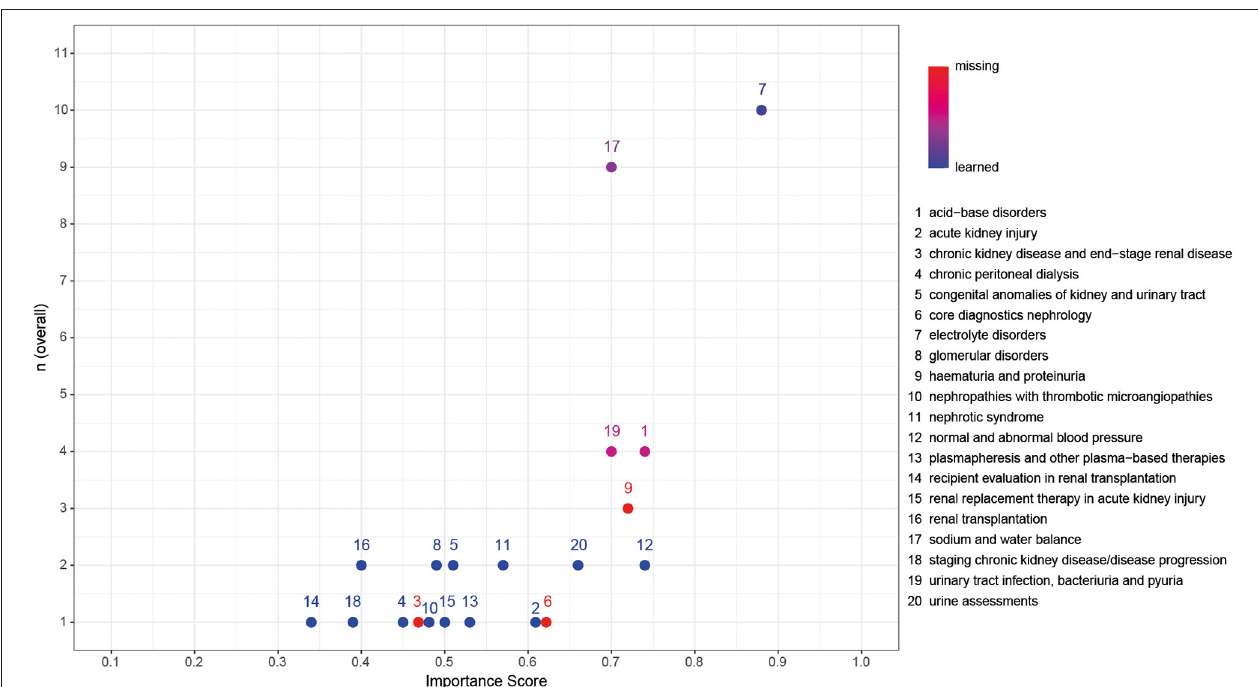
FIGURE 2 | Validation of the importance of key nephrology themes within the qualitative interviews with the calculated importance scores (IS) of the quantitative survey. Color coding represents classification as the ratio of missing:learned, with red representing 100% missing and blue representing 100% learned. Kendall’s rank correlation tau = 0.57, p =